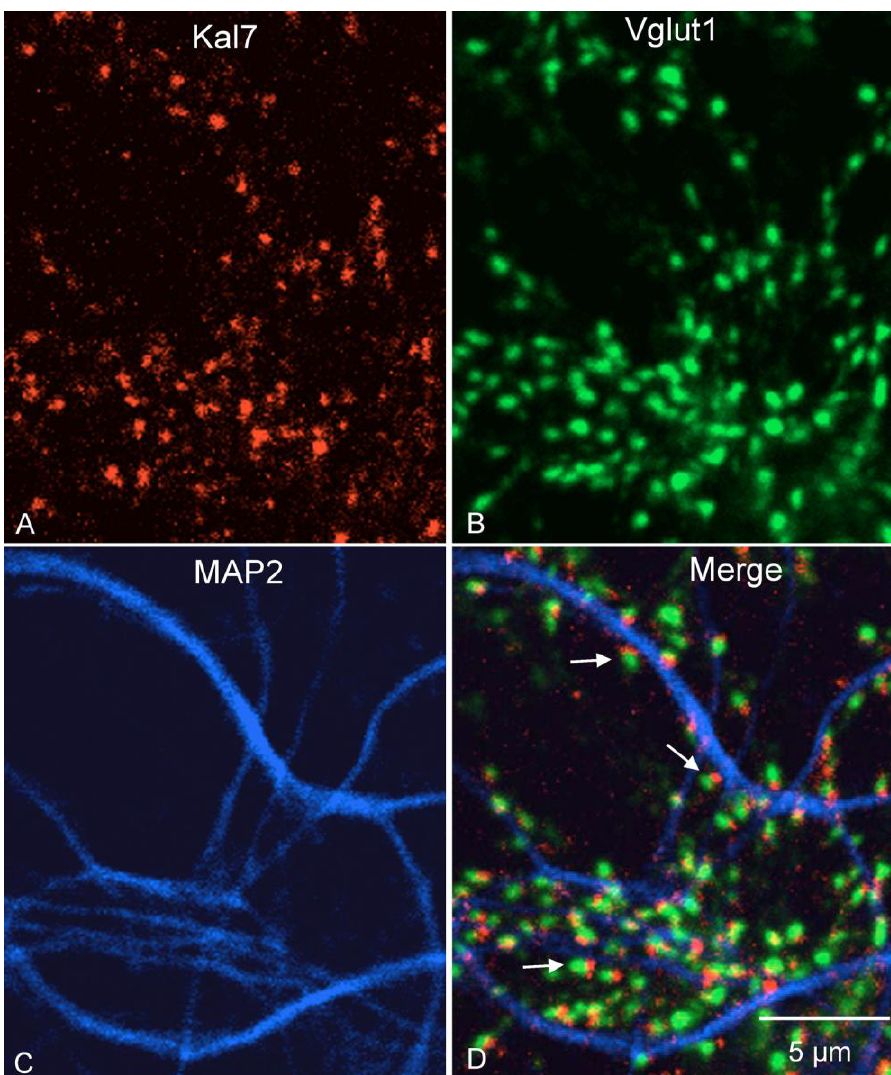
FIGURE 2. Kal7 is localized to the postsynaptic side of excitatory synapses in hippocampal neurons. The dendrites of mature hippocampal neurons (DIV30) were fixed with cold methanol and simultaneously stained for Kal7 (A, red), Vglut1 (B, green, a marker for excitatory presynaptic terminals), and MAP2 (C, blue, dendritic marker), showing that Kal7 is localized to the postsynaptic side of excitatory synapses (D, merge). Neuronal preparation and immunostaining were performed as